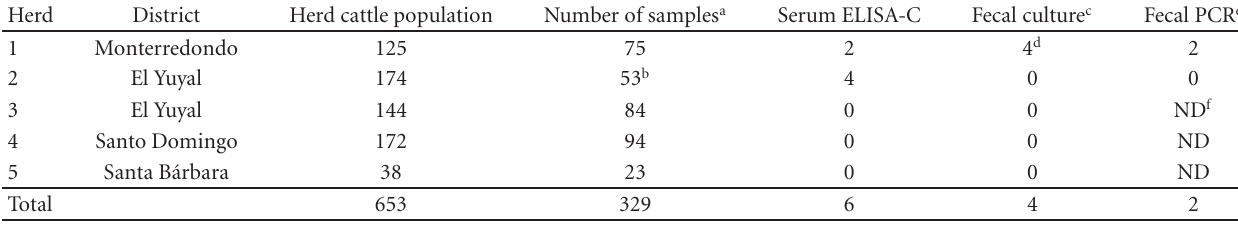
Table 2: Enzyme-linked immunosorbent assay (ELISA), polymerase chain reaction (PCR) and fecal culture positive results of five dairy herds examined for Map in Colombia.